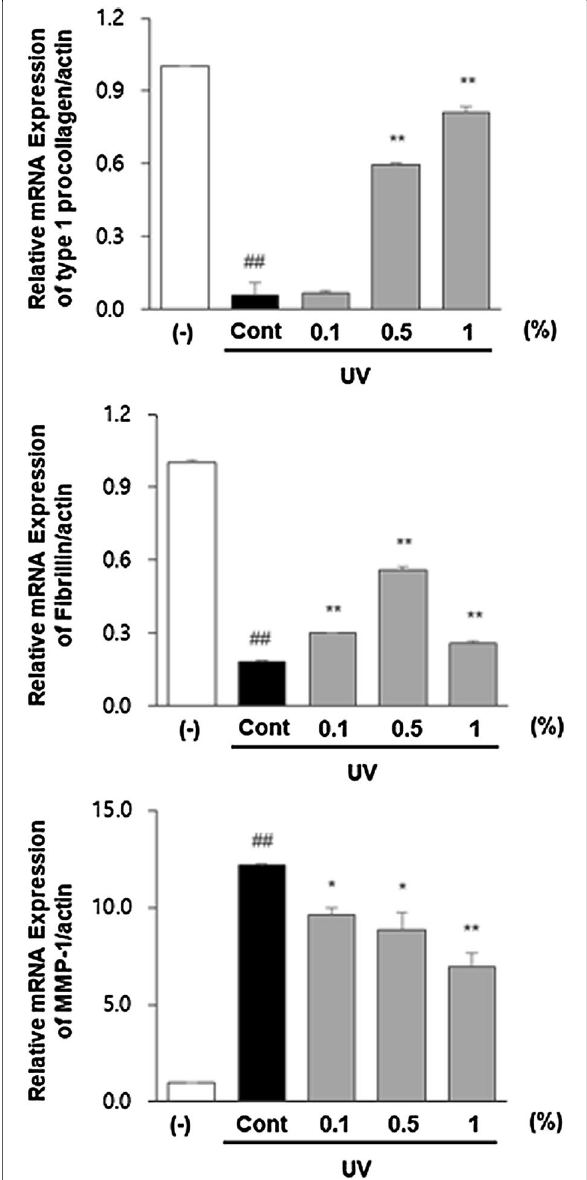
Fig. 4 The effect of EPI‑7 T culture solutions on the regulation of anti‑aging associated mRNA expressions in UV‑irradiated